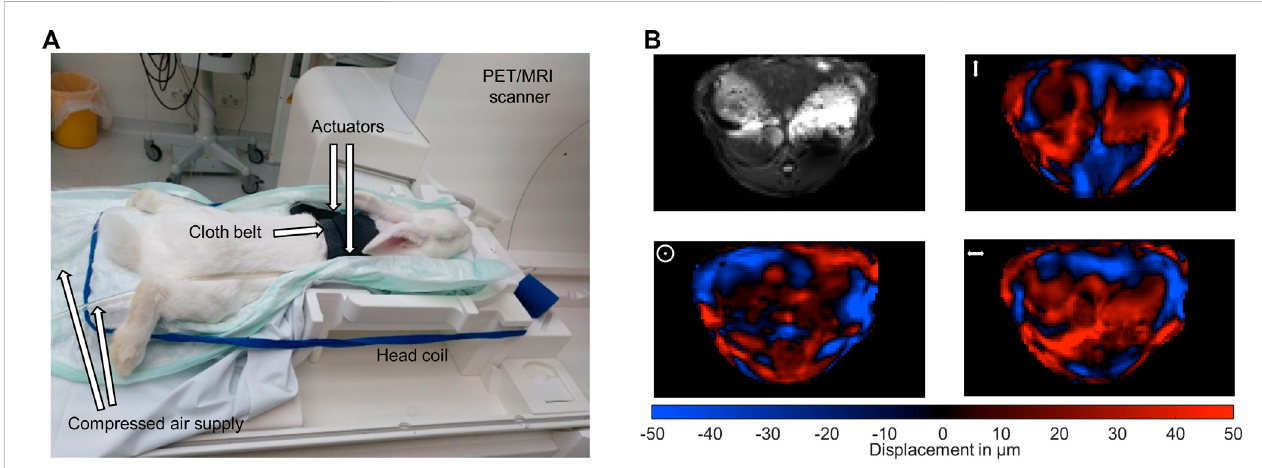
Experimental setup. (A) Multifrequency MRE setup for abdominal investigations in rabbits in a 3-Tesla PET/MRI scanner using a 20-channel head coil. Harmonic oscillations are generated by pressurized air pulses transmitted via tubes into two plastic actuators. The two actuators are placed in the upper abdominalregionoftherabbits. (B) RepresentativeMREmagnitudeimage(greyscale)andwave fi elds(colorscale)forthethreemotionencodingcomponents at 60 Hz vibration frequency. Mean displacement for the three motion encoding components was 31 µm. The symbols h , ʘ , ↔ illustrate head-feet, ventral-dorsal and left-right, de fl ections,